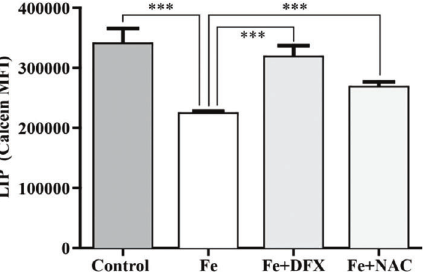
Figure 4. Reactive oxygen species (ROS) levels of Lin-Sca-1 + c-kit (LSK) + cells in iron overload (Fe) mice and after the administration of deferasirox (DFX) or N-acetyl-L-cysteine (NAC), in mean fl uorescence intensity (MFI). Data are reported as means ± SD. *P o 0.05